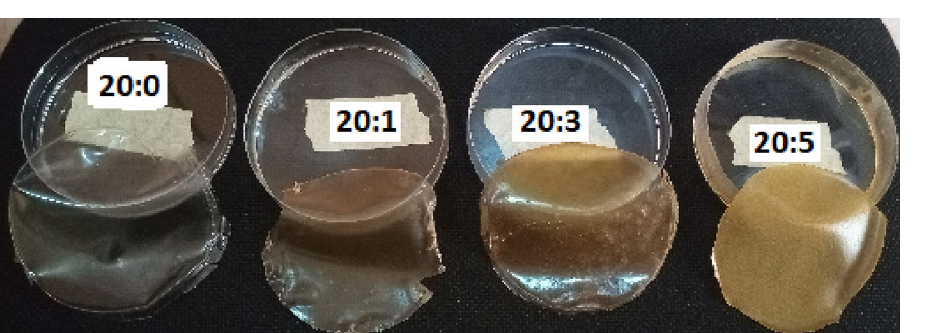
Figure 3. Images bio-composite films made with different blends of keratin and starch solutions. Note: 20:0, 20:1, 20:3, and 20:5 = starch/keratin ( v / v